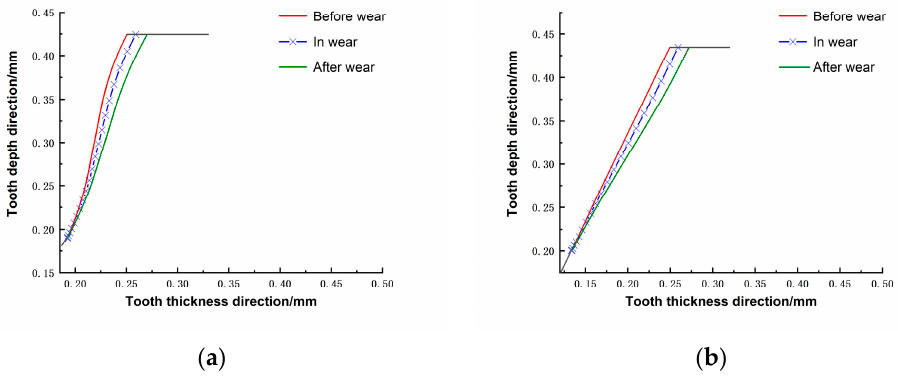
Figure 11. Wear tooth profile change: ( a ) double-arc; ( b ) involute.